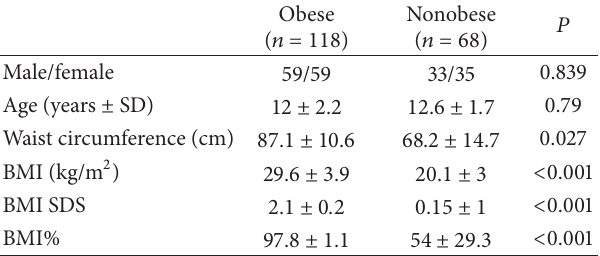
Table 1: Mean anthropometric data of the study and control groups.